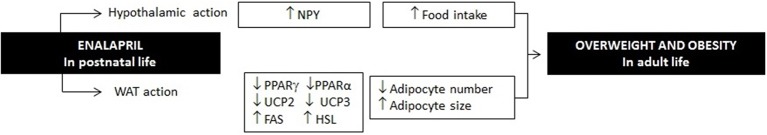
Enalapril administration in rats in postnatal life increases hypothalamic NPY gene expression, decreases expression of PPAR in the WAT and leads to long term consequences in metabolism, WAT cellularity and obesity.